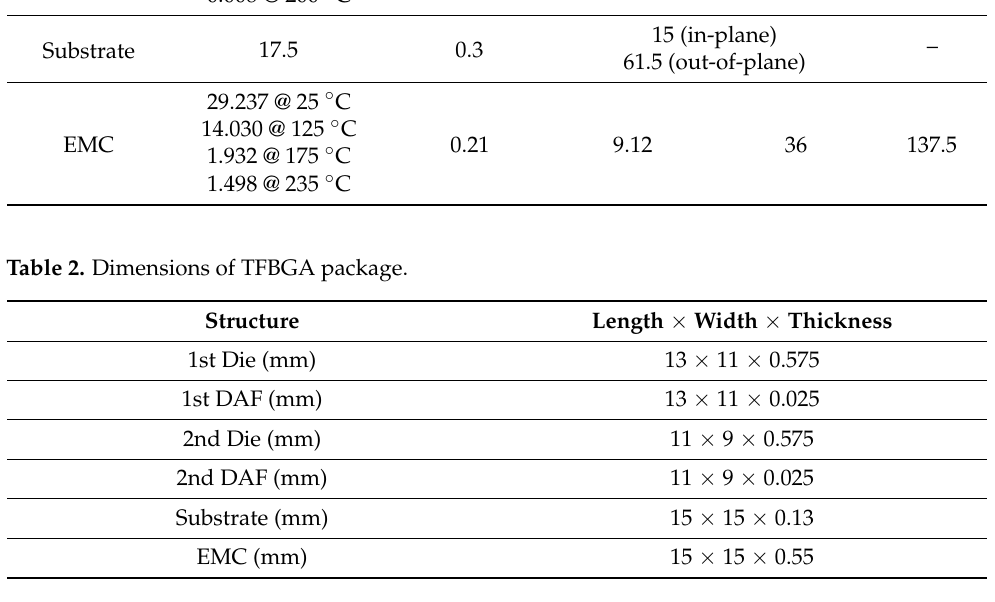
Figure 3. Quarter FE model of TFBGA package: ( a ) boundary conditions; ( b ) die stack configuration; and ( c ) enlarged view of cross-section.